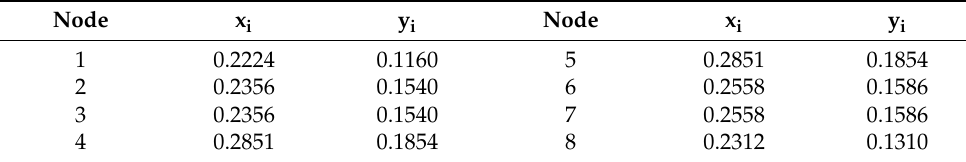
Table 3. Temperature calculation results of each node.